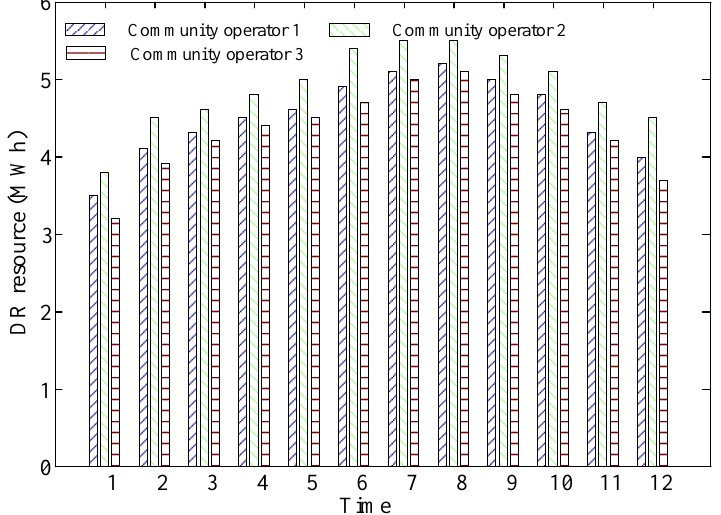
Figure 2. DR resources of 3 community